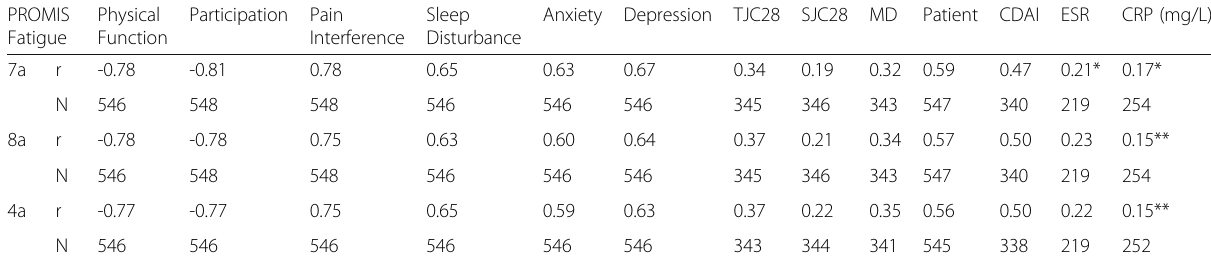
Table 4 Correlation of PROMIS fatigue short forms with other PROMIS measures and other clinical disease indicators of RA PROMIS Fatigue